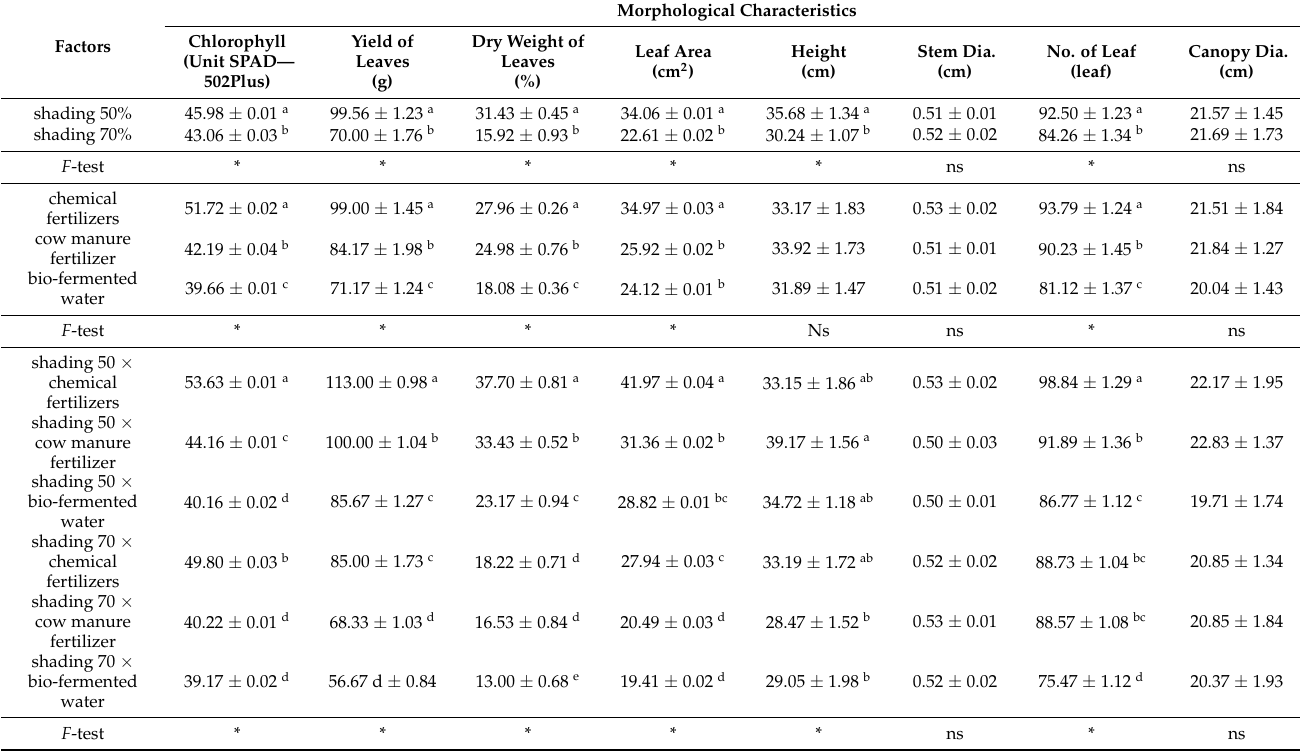
Table 1. Morphological characteristics of the Niamhom plant after one-month